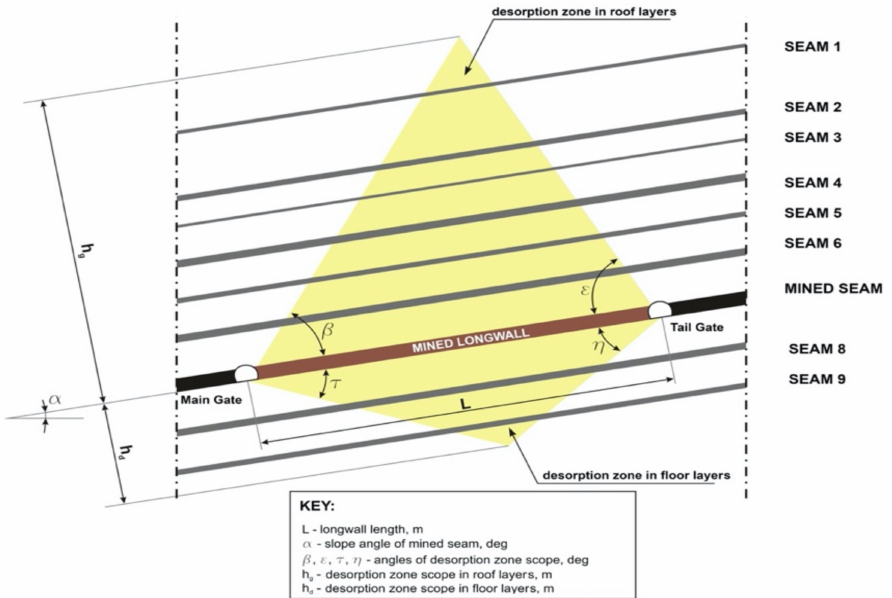
Figure 6. Diagram illustrating the designation of the desorption zone for the longwall in operation (adapted from [51]).